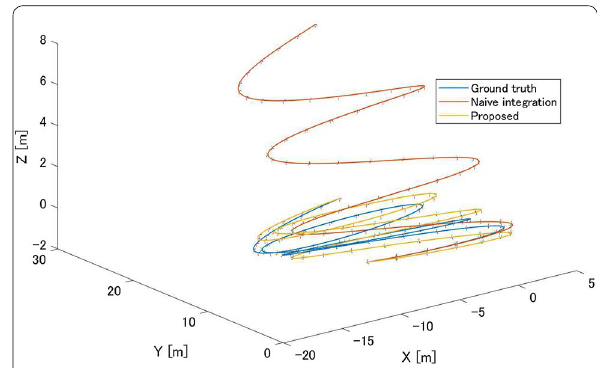
Fig. 2 Sample trajectory estimation result